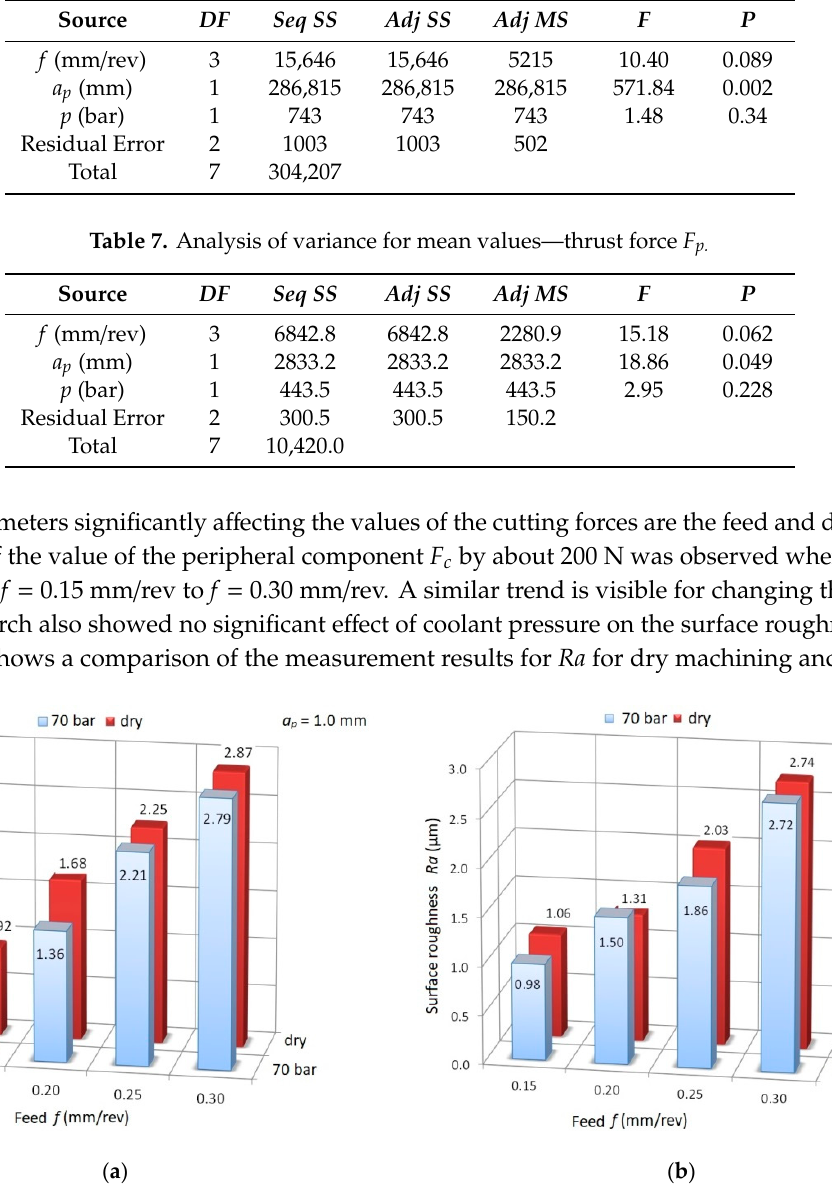
Figure 7. Dependence of surface roughness ( Ra ) for dry and high-pressure cooling (HPC) turning for ( a ) cutting depth a p = 1.0 mm; ( b ) cutting depth a p = 3.0 mm.